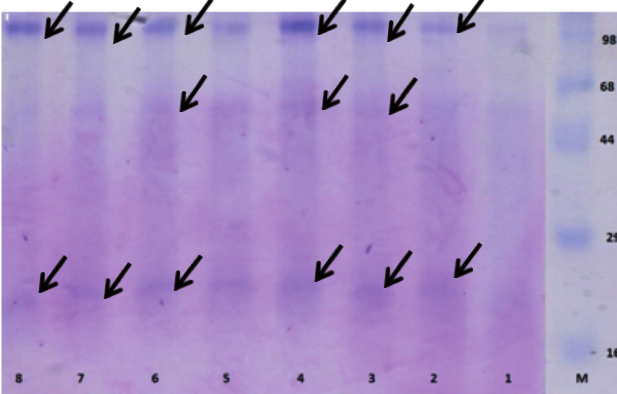
Fig. 8: Comparative analysis of protein banding pattern of the two canola cultivars. Lanes 1-4, Dunkled; Lanes 5-8, Cyclon. Lane 1: Control, Lane 2: GB (100 mM), Lane 3: Salt (150 mM), Lane 4: GB + Salt. Similar sample arrangement is for Cyclon cultivar in Lanes 5-8. Molecular weights of the marker proteins are given in kDa.